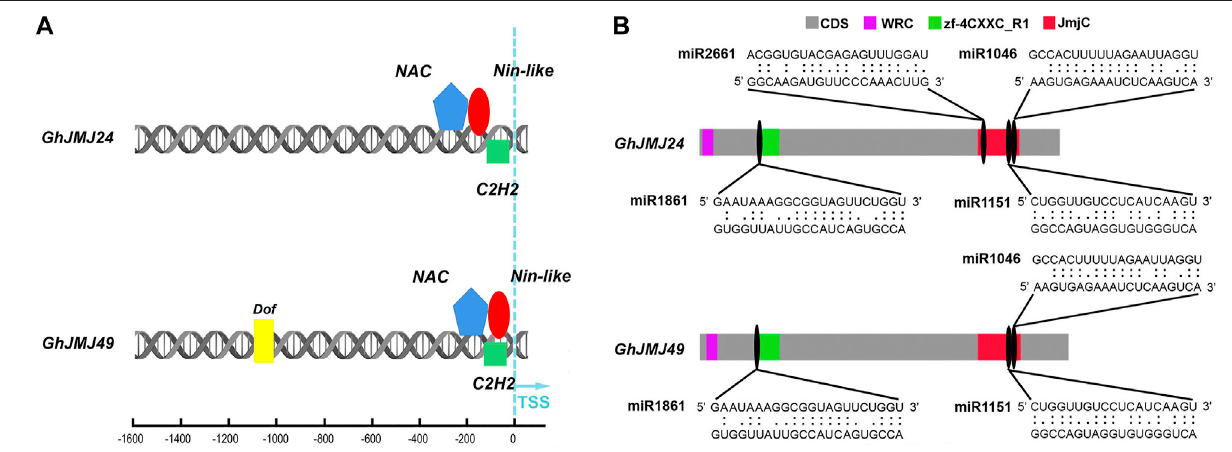
FIGURE6| Schematicdiagram ofthetranscription factor bindingsites(TFBS)and miRNA complementarybindingsitesof GhJMJ24 and GhJMJ49 . (A) .TFBSsin theupstreamsequencesof GhJMJ24 and GhJMJ49 .ColoredshapesdepictputativeTFBS. (B) .ThemiRNA-mRNAregulatoryrelationshipsinthedomainsof GhJMJ24 and GhJMJ49 . Grey boxes represent the CDS (open reading frames) of genes. JmjC domain, zf-4CXXC_R1 domain and WRC domain are shown in red, green, and purpleboxes, respectively.ThemiRNAcomplementary bindingsitesare markedbyblack ovals,and complementarysequences (5 – 3 ′ )areshown intheexpanded regions.